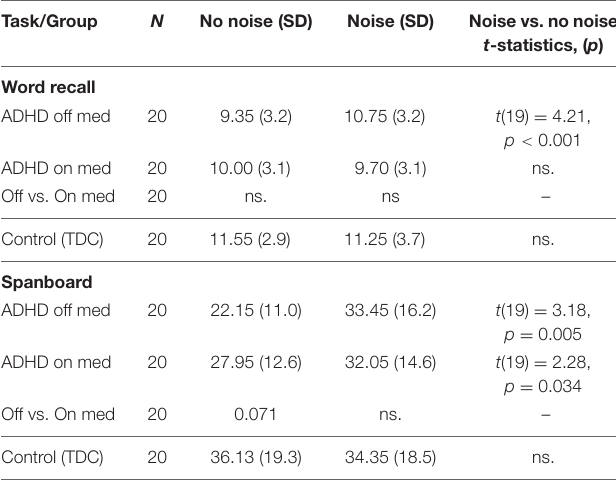
TABLE 2 | Results on Word Recall and Spanboard task for ADHD and control children (TDC) in noise and in silence. Task/Group